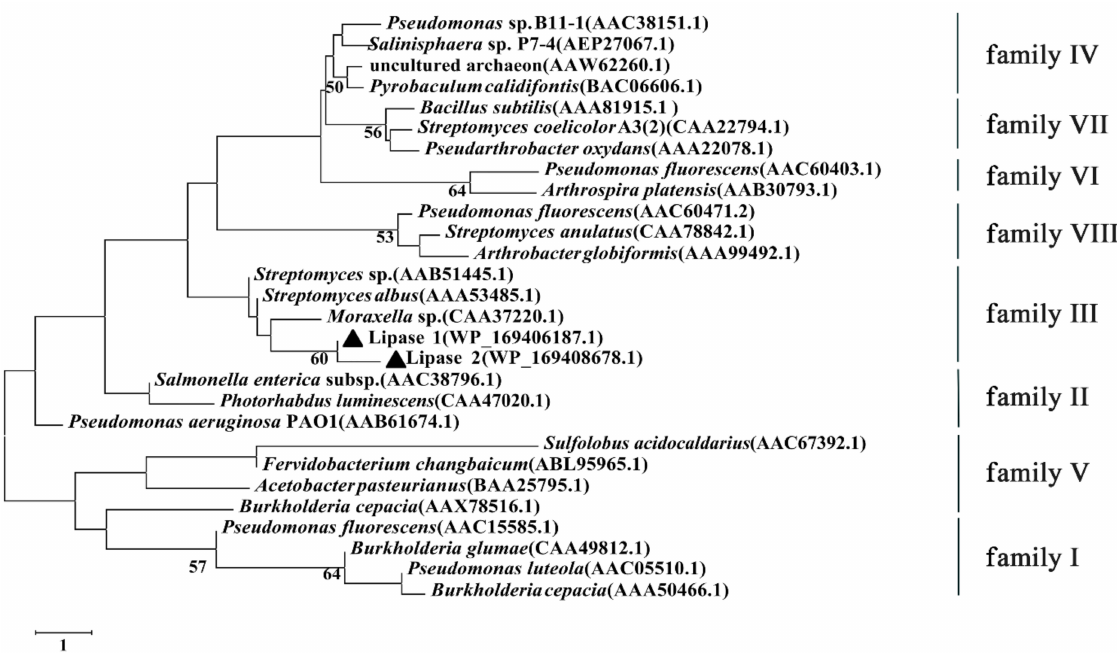
Figure 8. Phylogenetic tree of Lipase 1 and Lipase 2 based on conserved amino acid sequences. The black triangle represents the evolutionary position of Lipase 1 and Lipase 2. Bootstrap values at nodes were derived from 1000 replicates. Only bootstrap values higher than 50% were shown. Bar, 1 substitution per nucleotide